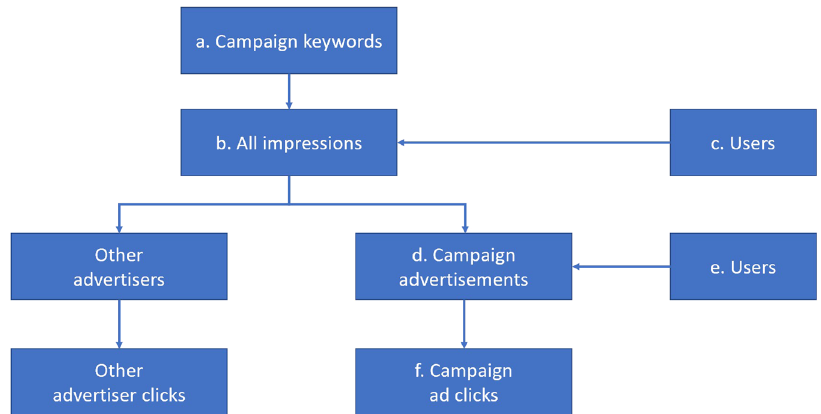
Fig. 1 Flowchart of the advertising campaign. Letters refer to the numbers shown in Table 1.